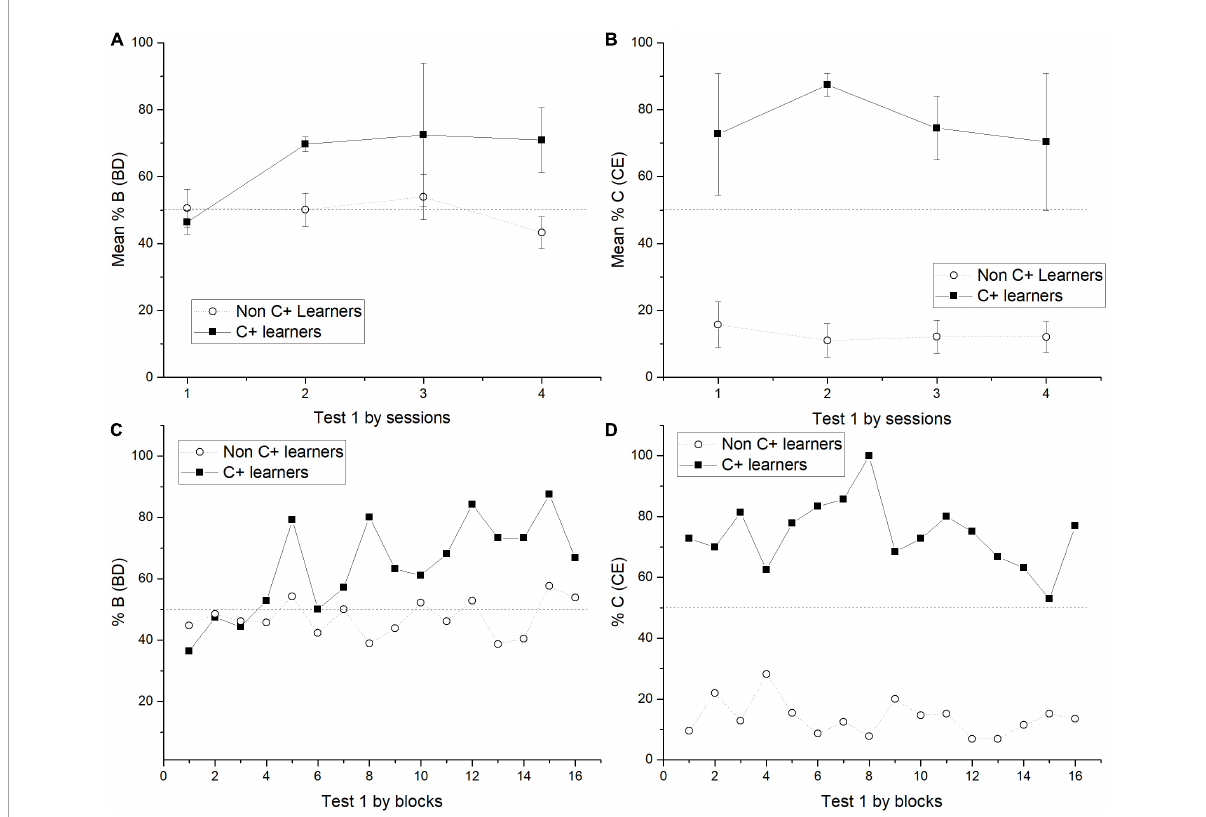
FIGURE5 Mean percentage (SEM ± ) of correct responses in BD across sessions during test 1 for BD (A) and CE (B) , including C + learners and non C + learners. Block analysis for BD preference in test 1 includes both subgroups, each block contains 50 trials. So that, the X axis includes 16 blocks of 50 trials taken from four test sessions (C) . Block analysis for CE preference in test 1 (D)